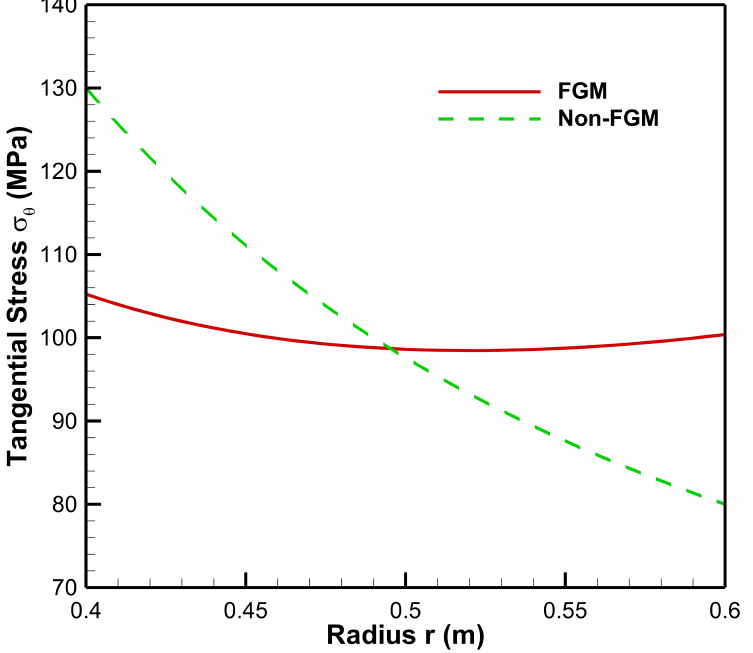
Figure 6. Tangential stress along the radius of the cylinder under internal pressure, P a = 50 MPa.